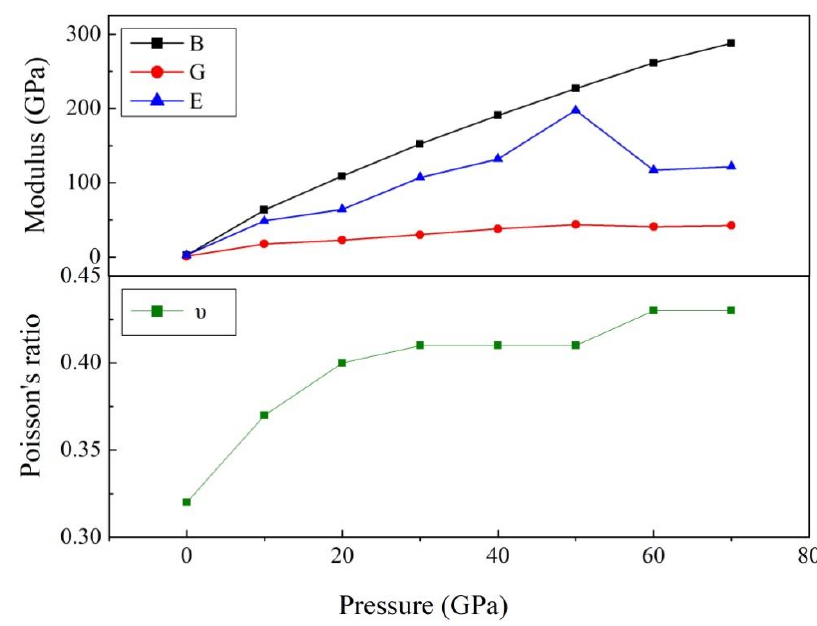
Figure 4. The modulus and Poisson's ratio of DNTF under different pressure.